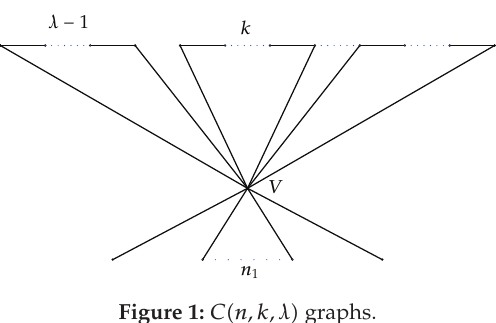
Figure 1: C (cid:2) n,k,λ (cid:3)